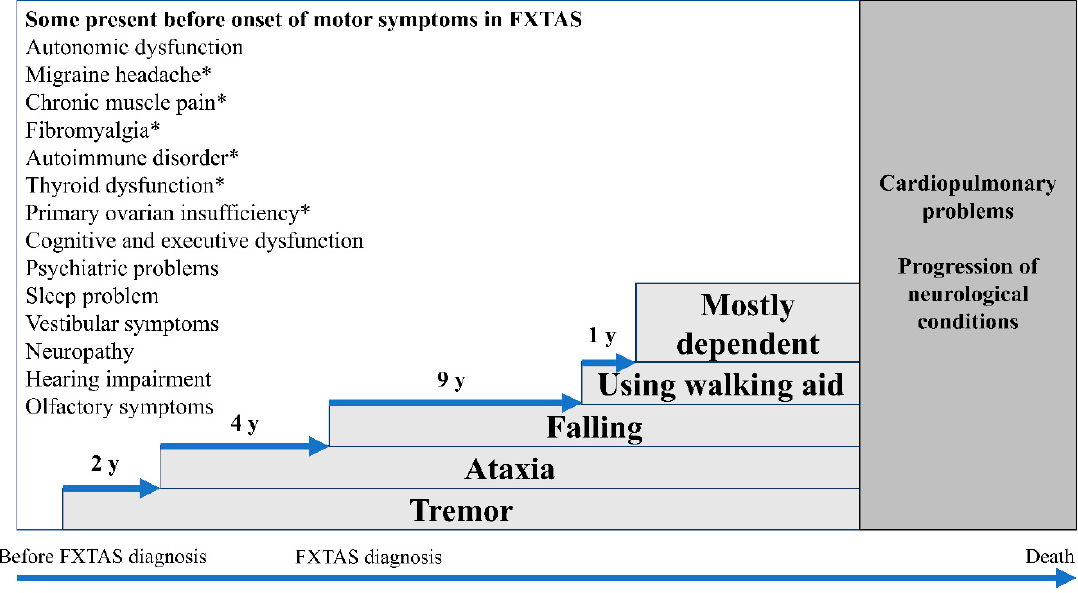
Figure 1. Clinical manifestations of the fragile X premutation and fragile X-associated tremor / ataxia syndrome (FXTAS) overtime. * Clinical manifestations which are more prevalent in females with the fragile X premutation than males. (Adapted from Leehey et al. 2007; Greco et al. 2006) [42,75].